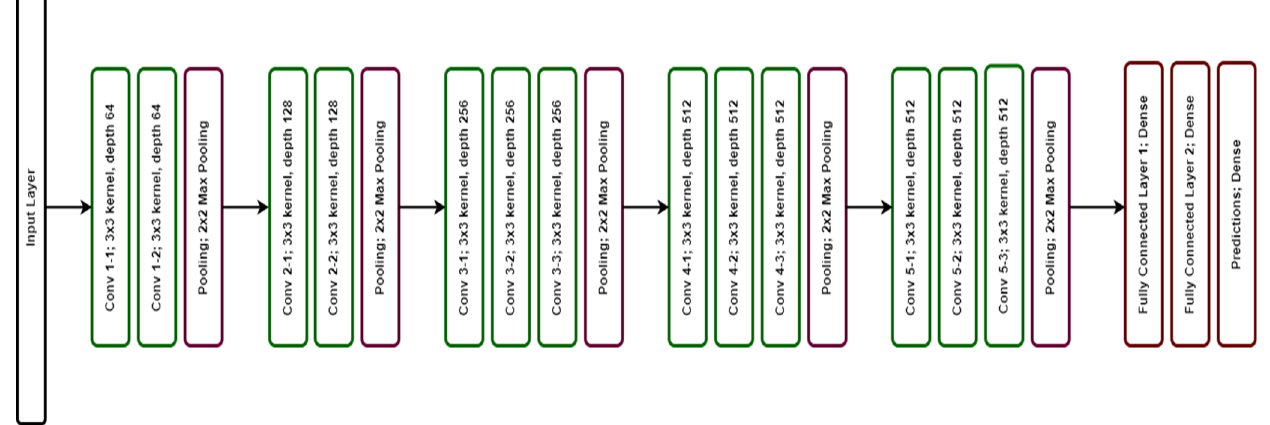
Figure 3. Block schematic of the VGG16 architecture.